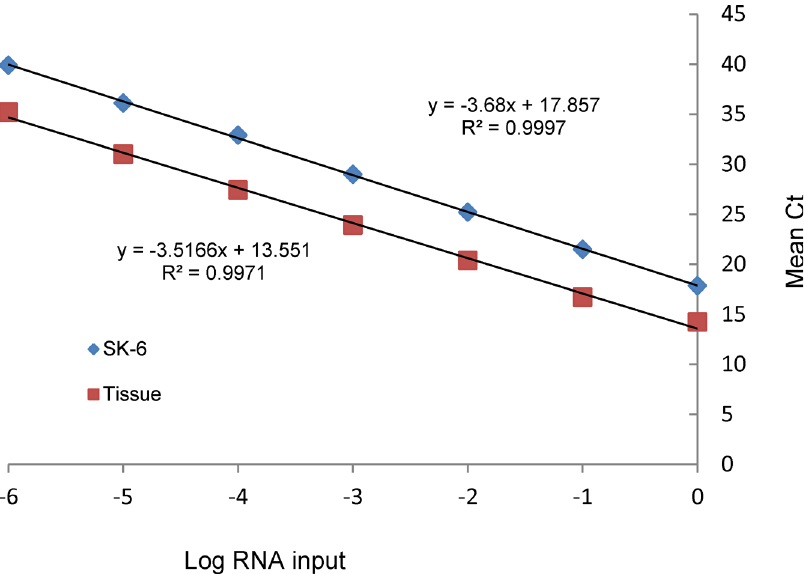
Fig 5. RT-qPCR linearity and sensitivity. Serial dilutions of standard control and SV-A positive tissue RNA produced linear standard amplification plot up to extinction with y-slopes of (-3.68 and -3.51, respectively) demonstrated > 90% RT-qPCR efficiency with r 2 > 0.99.